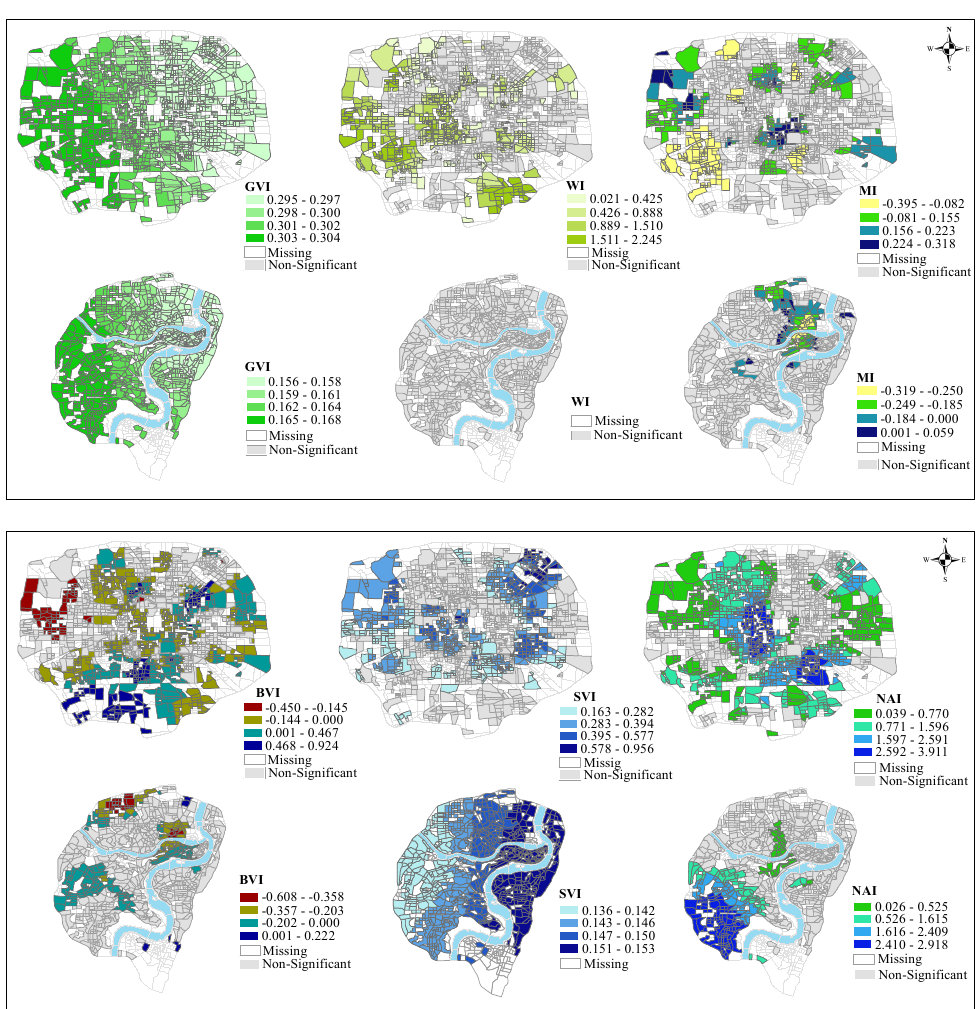
Figure 5. Spatial distribution of MGWR visual factor coefficients in Beijing and Chongqing.